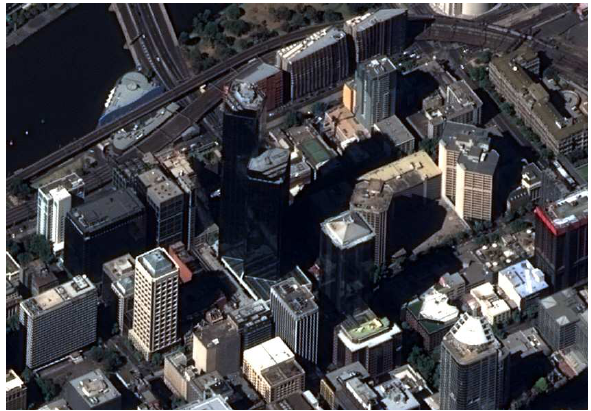
Figure 1 : Pleiades-HR Pan-sharpened image of